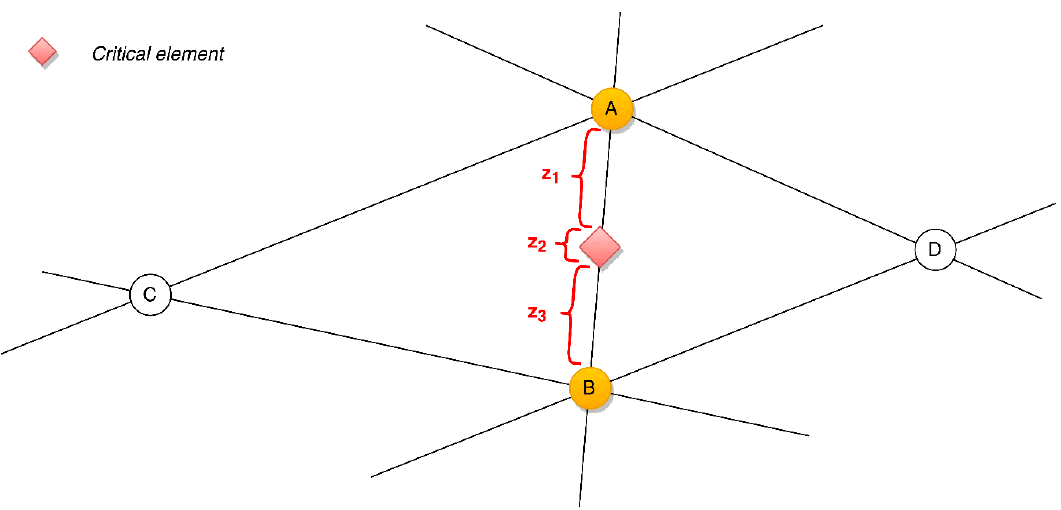
Figure 8. Graphic depiction of a road with an identified critical element.